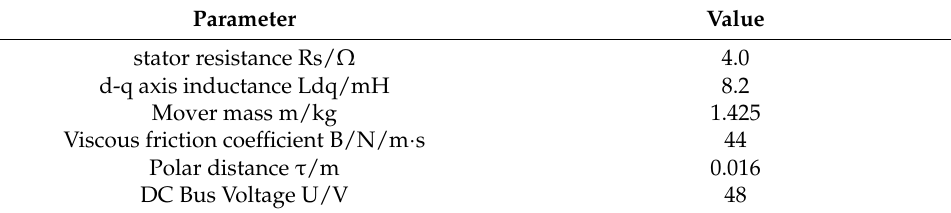
Figure 3. Control system block diagram. Table 2. Main parameters of straight line.